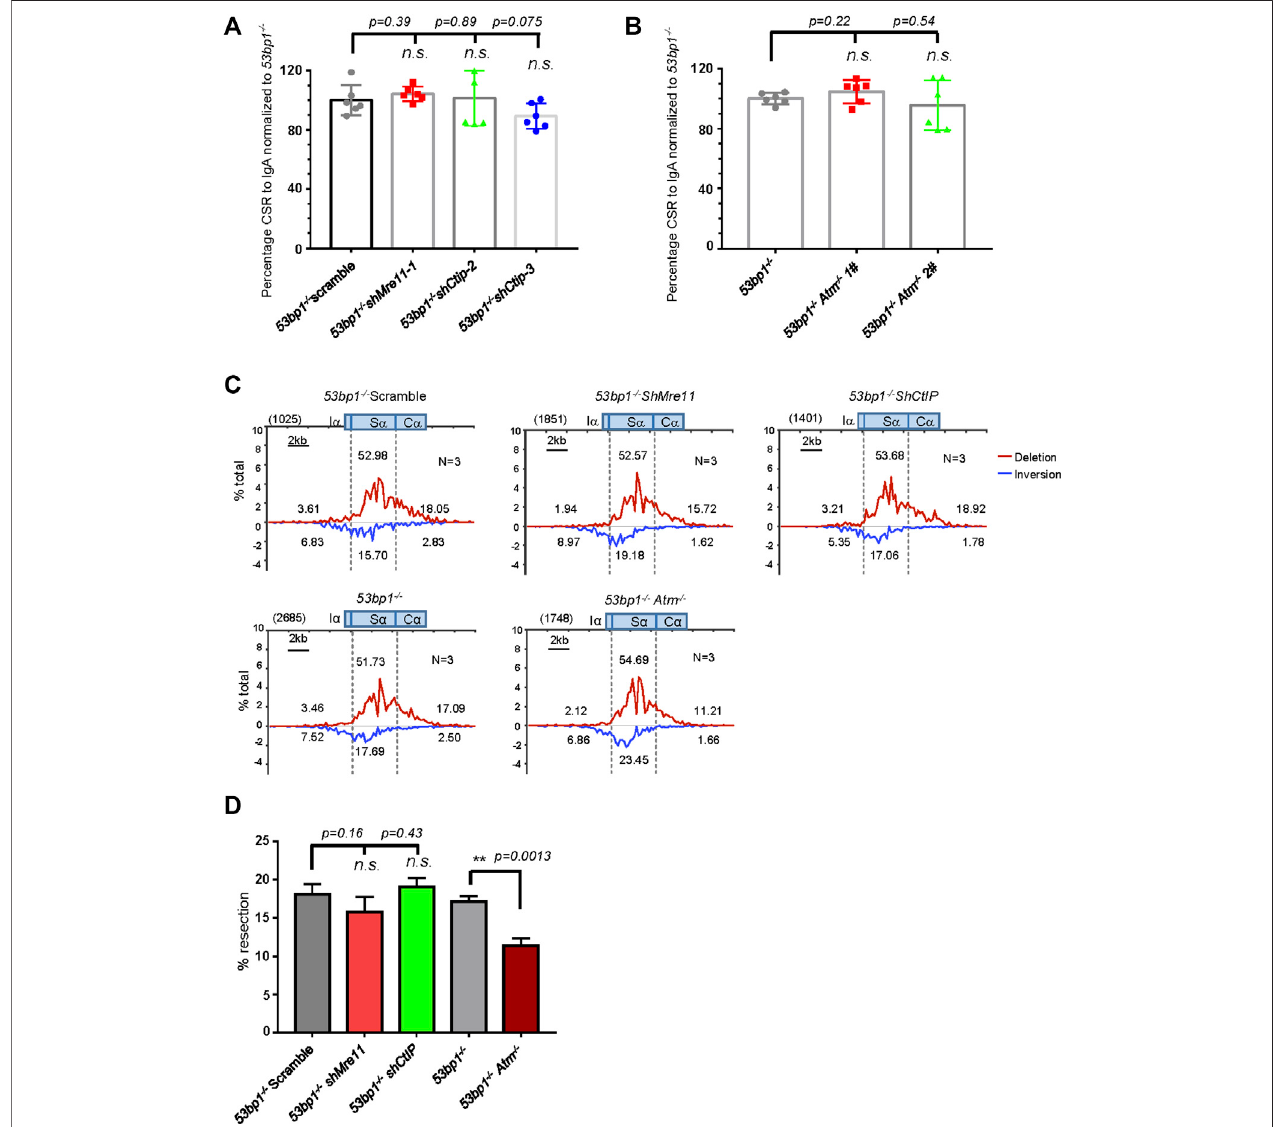
FIGURE 6 | Mre11/CtIP and ATM are not required for CSR in 53bp1 − / − cells. (A) Silencing Mre11/CtIP did not affect IgA CSR in 53bp1 − / − cells. Data were presentedasmean ± SDfromsixindependentexperiments(Student ’ s t -test,n.s.( p > 0.05)indicatesnon-signi fi cantdifferences). (B) NormalizedlgAswitchingef fi ciency in Atm -deleted 53bp1 − / − cells. Data were presented as mean ± SD from six independent experiments (Student ’ s t -test, n. s. ( p > 0.05) indicates non-signi fi cant differences). (C) Linear distribution of pooled S μ -S α junctions recovered from HTGTS libraries with CSR activated Mre11/CtIP-silenced and ATM knockout 53bp1 − / − cells. Numbers ( N ) indicated experiment repeats. (D) Percentage of long resection junction in S μ -S α junctions recovered from HTGTS libraries with Mre11/ CtIP-silenced and ATM-de fi cient 53bp1 − / − cells. CSR and HTGTS analysis were assayed at 72 h after stimulation with α -CD40/IL-4/TGF- β . Data were presented as mean ± SEM (Student ’ s t -test, * p < 0.05, ** p < 0.01, n. s. ( p > 0.05) indicates non-signi fi cant differences).